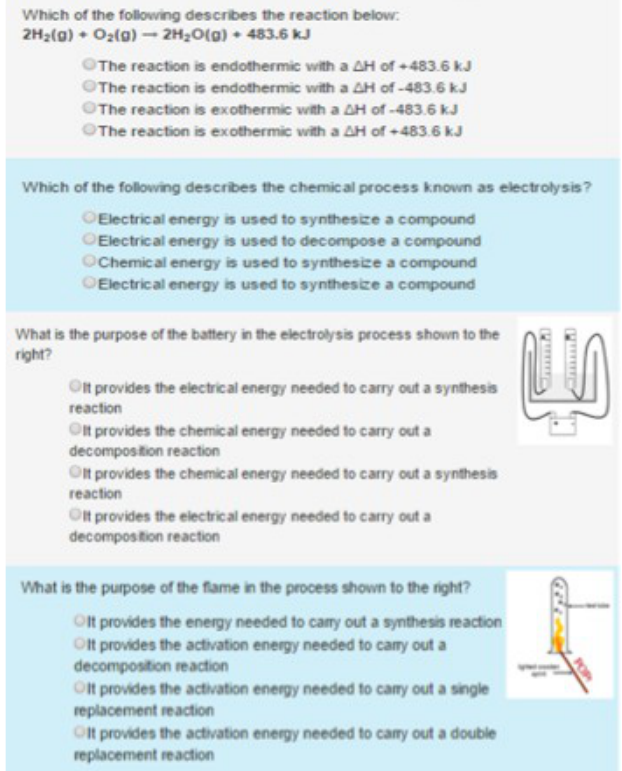
Figure 1. Pre-lab questions and visual aids created to help the students understand the purpose of a battery in an electrolysis process and a flame in hydrogen formation